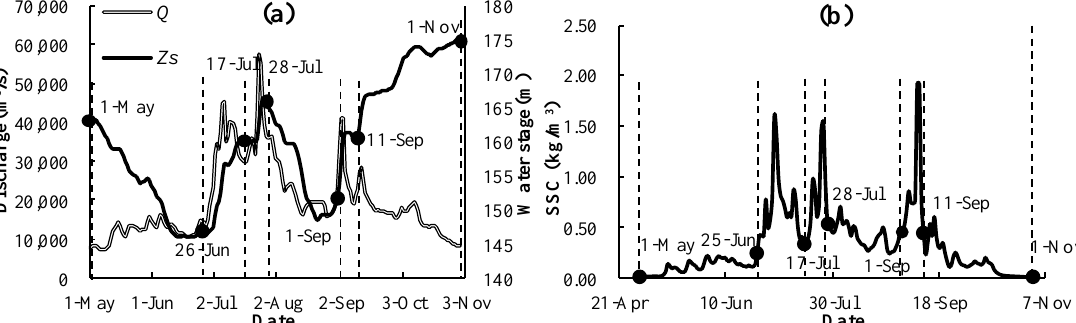
Figure 3. ( a ) Hydrograph at Qingxichang (QXC) and Wanxian (WX) gauging stations. ( b ) Sediment discharge ( Q S ) measured at QXC and WX and calculated at HHC (The Q S at WX station has been moved forward by one day).